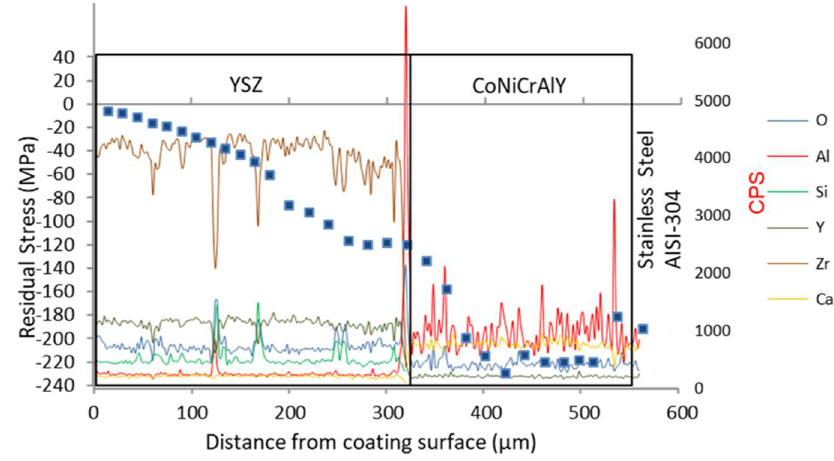
Figure 7. Residual stress caused by CMAS infiltration.